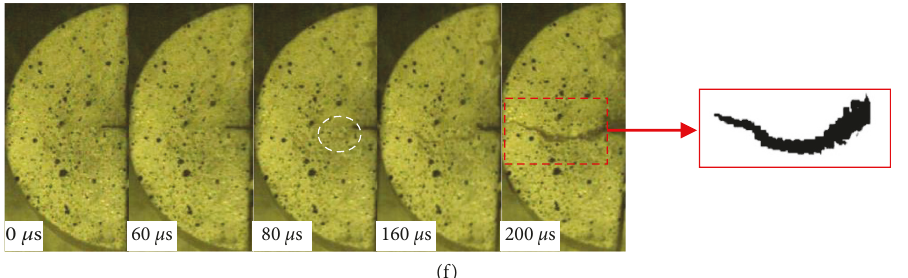
Figure 7: The failure processes and corresponding extraction of main crack path of binary images of the NSCB specimens: (a)–(f) corresponding to D c � 0, 1.16, 1.95, 3.02, 3.62,